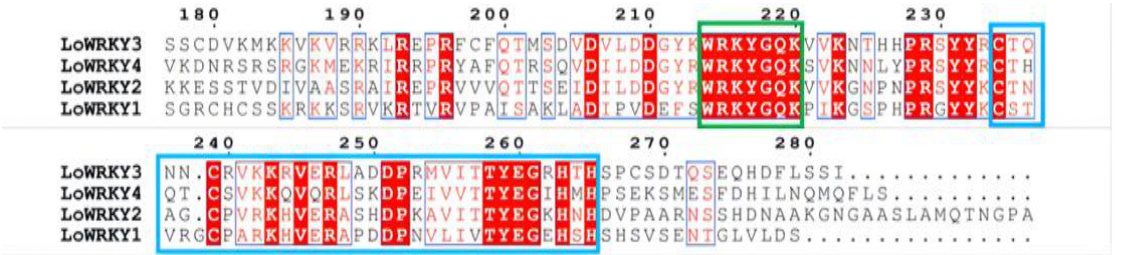
Figure 1. WRKY transcription factor family gene sequence alignment map (partial sequence). Note: WRKYGQK conserved domain is in the green box and zinc finger structure is in the blue box.